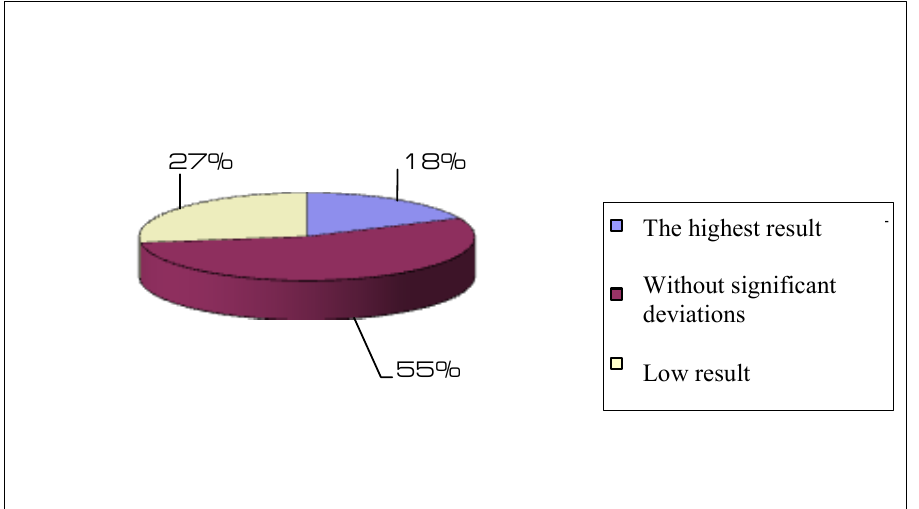
Fig.2. Results of comparative analysis of the tested before and after receiving